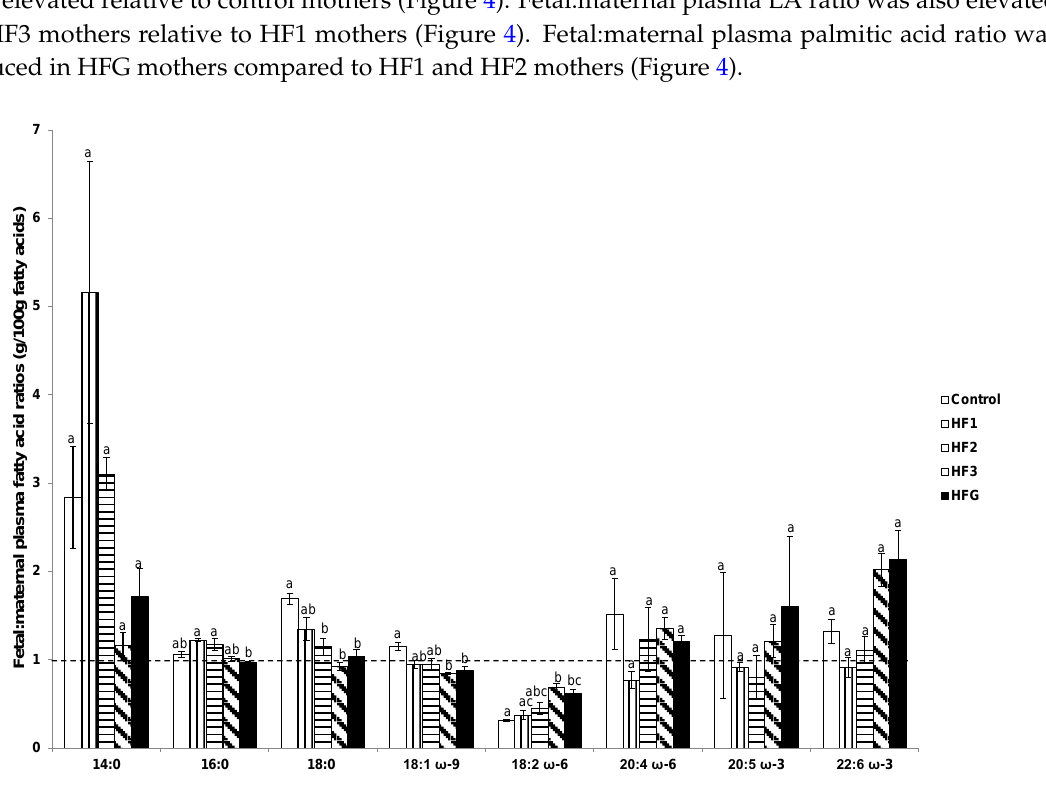
Figure 4. Fetal: maternal ratio of plasma fatty acids (g/100 g fatty acids). Numerals refer to the specific week of gestational high fat (HF) maintenance. G, gestation refers to HF maintenance throughout gestation. Values are means ± standard error of the mean (SEM). Different letters reflect significant changes.